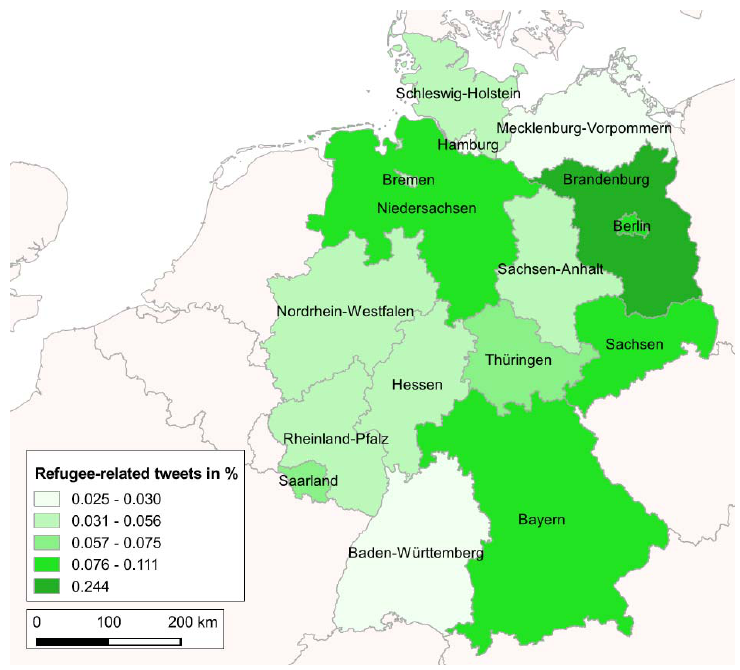
Figure 14. Percentage of refugee related tweets in federal states in Germany.